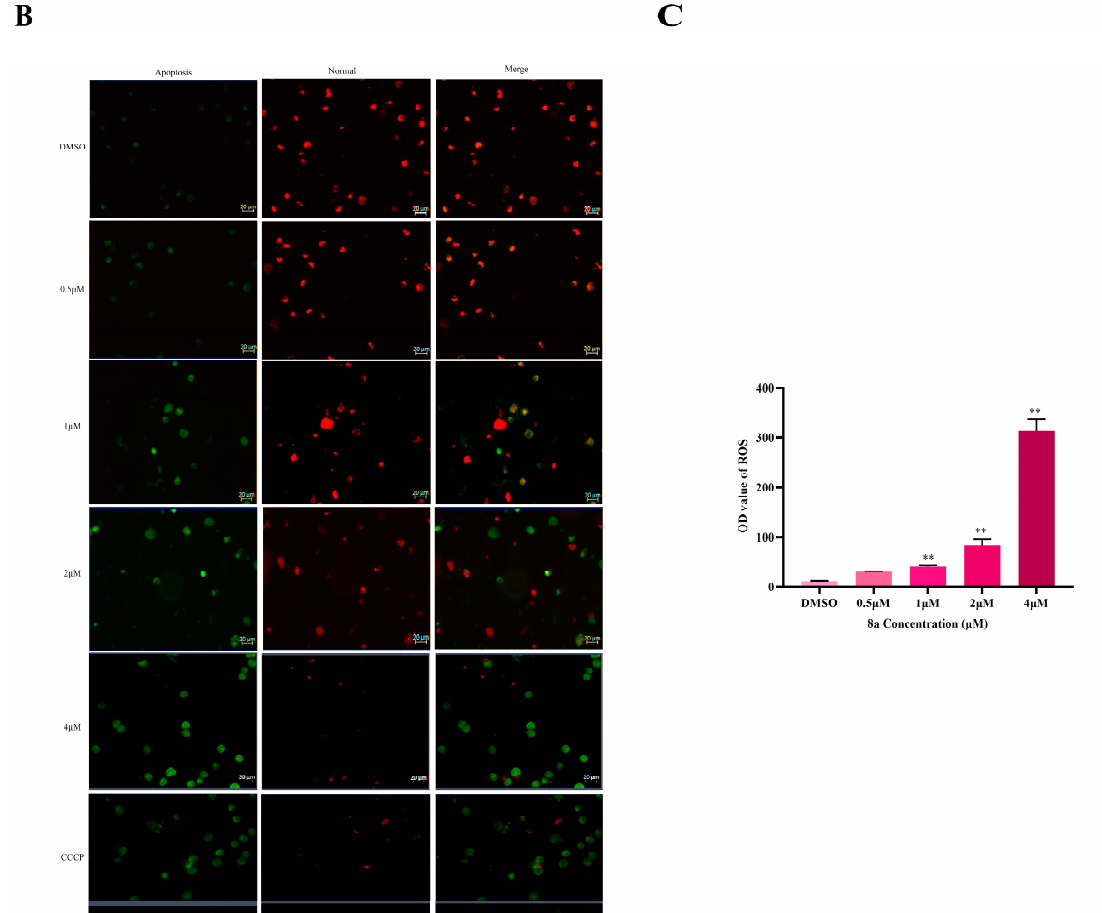
Figure 3. ( A ) Annexin V-FITC apoptosis assay. U937 cells were treated with different concentrations of 8a (1, 2, and 4 µ M) for different lengths of time (24, 48, and 72 h). Propidium iodide can stain necrotic cells or cells that have lost their cell membrane integrity in the late stage of apoptosis red fluorescence. Annexin V-FITC can enter the cytoplasm and bind to phosphatidylserine located on the inner side of the cell membrane, leading to the necrotic cells presenting green fluorescence; 0.1%DMSO was used as a control. ( B ) Mitochondrial membrane potential. Normal cells’ red fluorescence was reduced, and the green fluorescence of apoptotic cells was enhanced as the concentration of 8a increased (0.5, 1, 2, and 4 µ M); Carbonyl cyanate-3-chlorophenylhydrazone (CCCP) was the positive control, and 0.1%DMSO was used as the negative control. The normal cells showed red fluorescence, and the apoptotic cells showed green fluorescence. ( C ) Reactive oxygen detection. CellROX Deep Red Reagent probe was used to detect the changes of ROS in tumor cells induced by 8a . U937 cells were treated with different concentrations of 8a (0.5, 1, 2, and 4 µ M) for 48 h (** p < 0.01); 0.1%DMSO was used as a